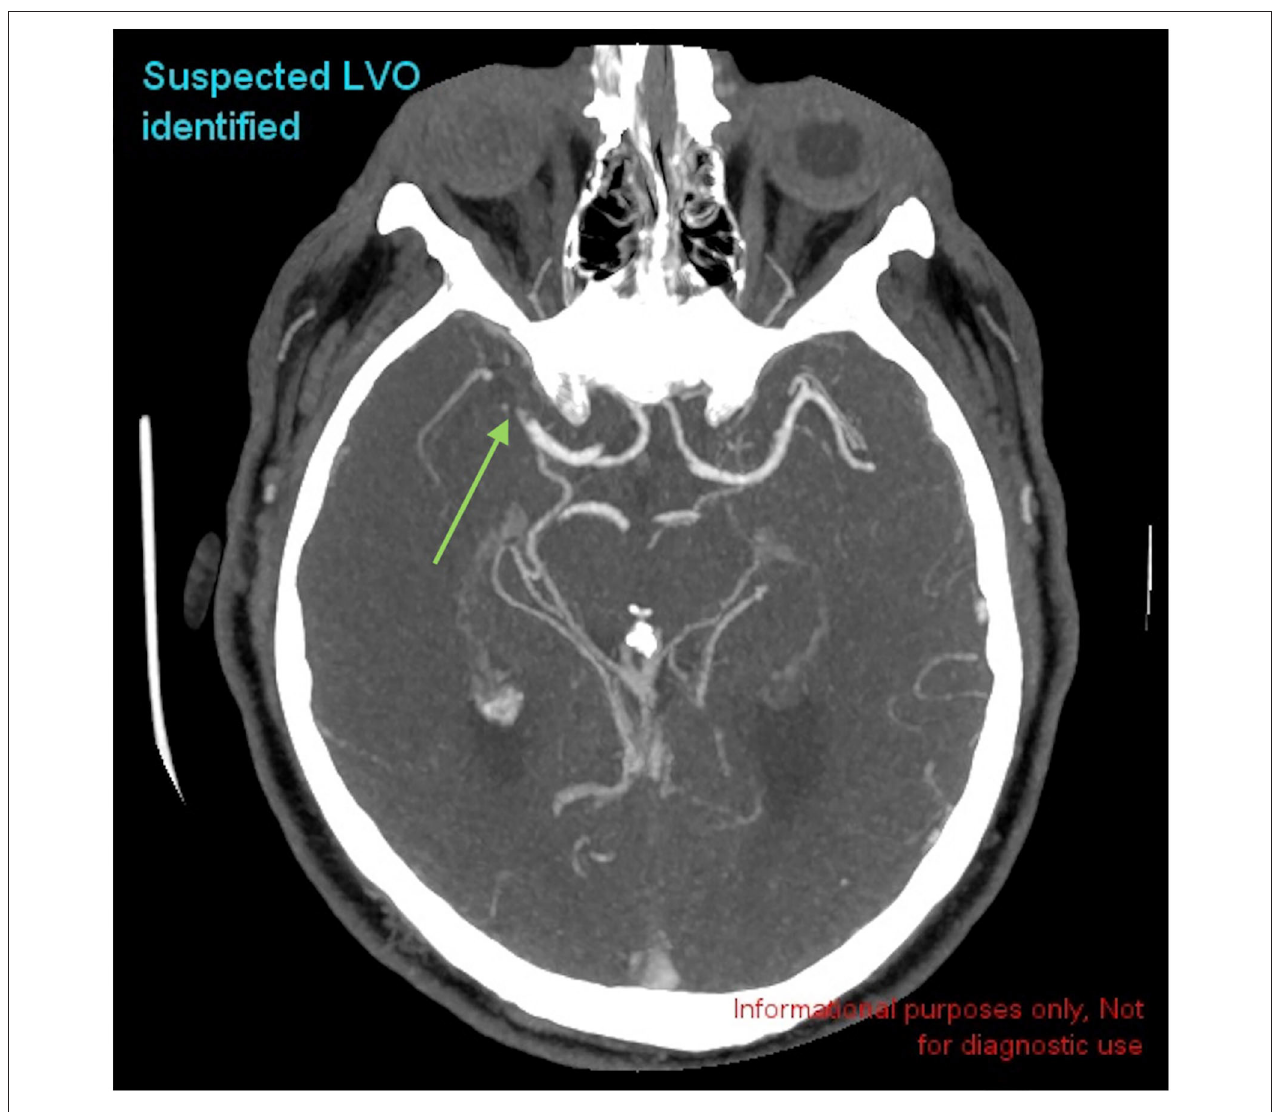
FIGURE 2 | Example of a positive LVO identified by CINA ® . There is a large vessel occlusion in the distal right MCA-M1 branch on CTA (green arrow).